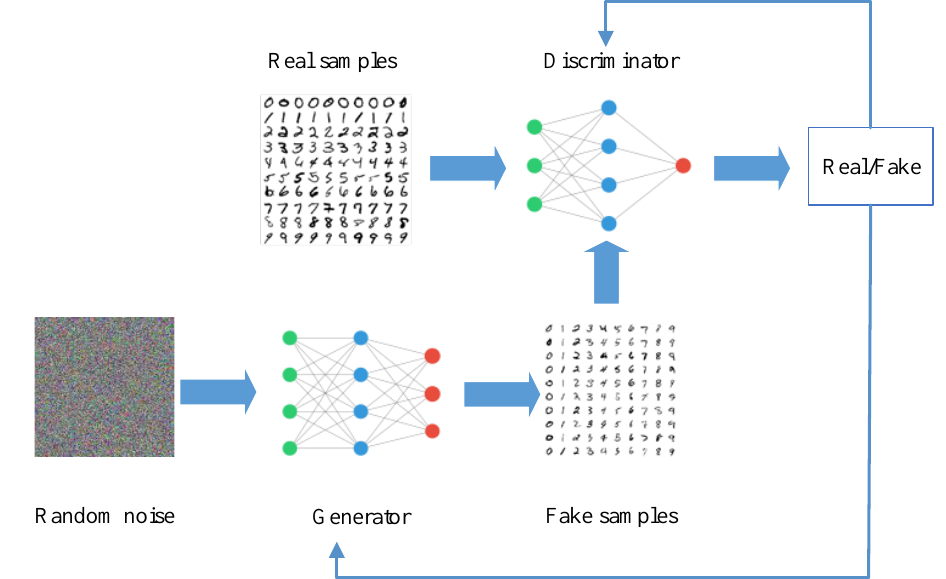
Figure 4. The classic GAN training process.